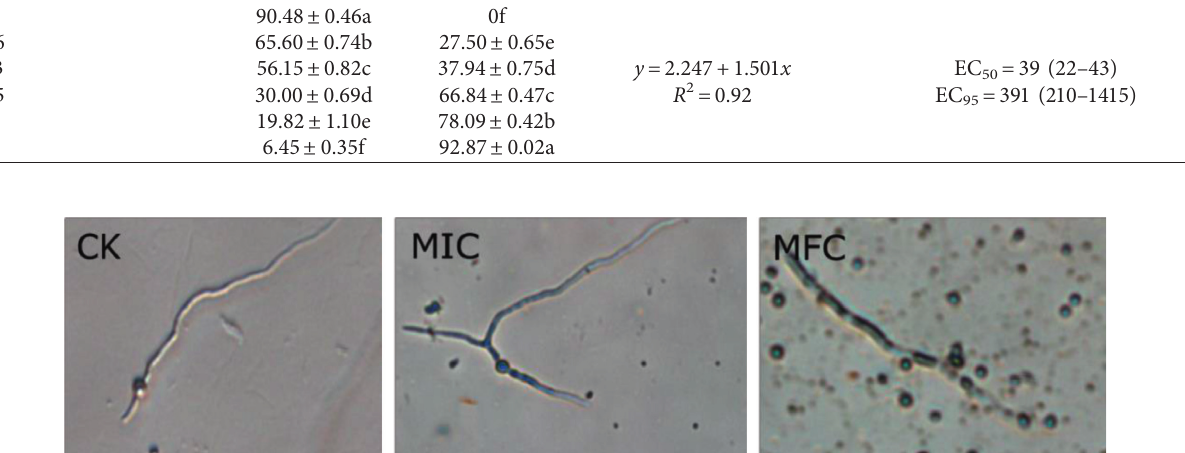
Figure 3: Effect of 4-methoxy CA on hyphal morphology of P. digitatum . Control, untreated mycelia; MIC, mycelia treated with 4-methoxy CA at 31.3 μ g/mL; MFC, mycelia treated with 4-methoxy CA at 125 μ g/mL. 300350400450500550600650700